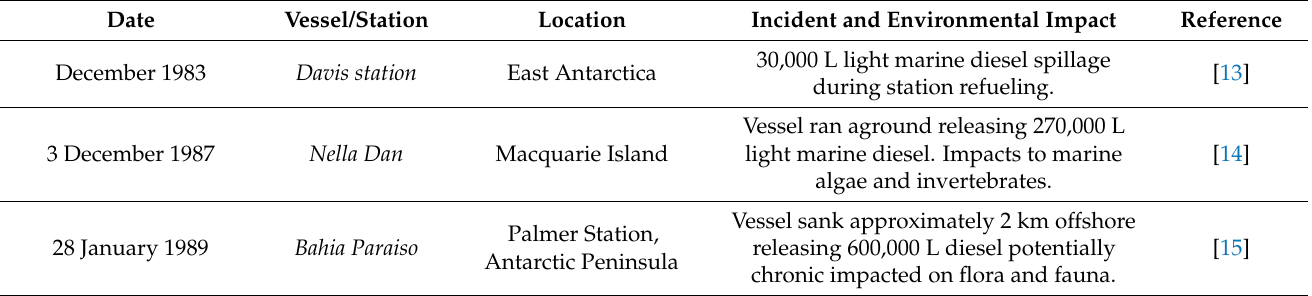
Table 1. Events in Antarctic and sub Antarctic with reported oil spillage into the marine